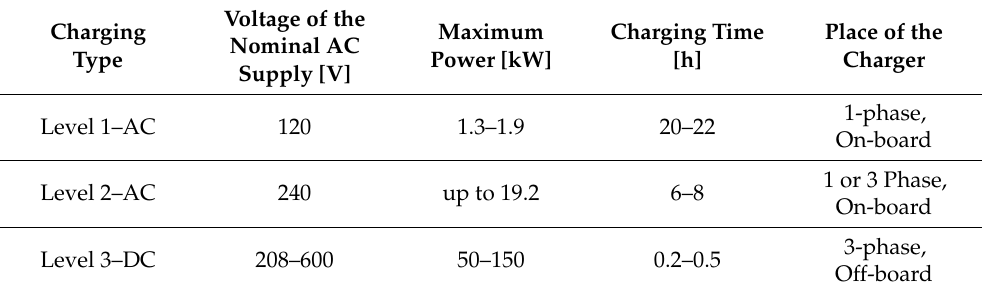
Table 1. Electrical quantities and types of charging methods